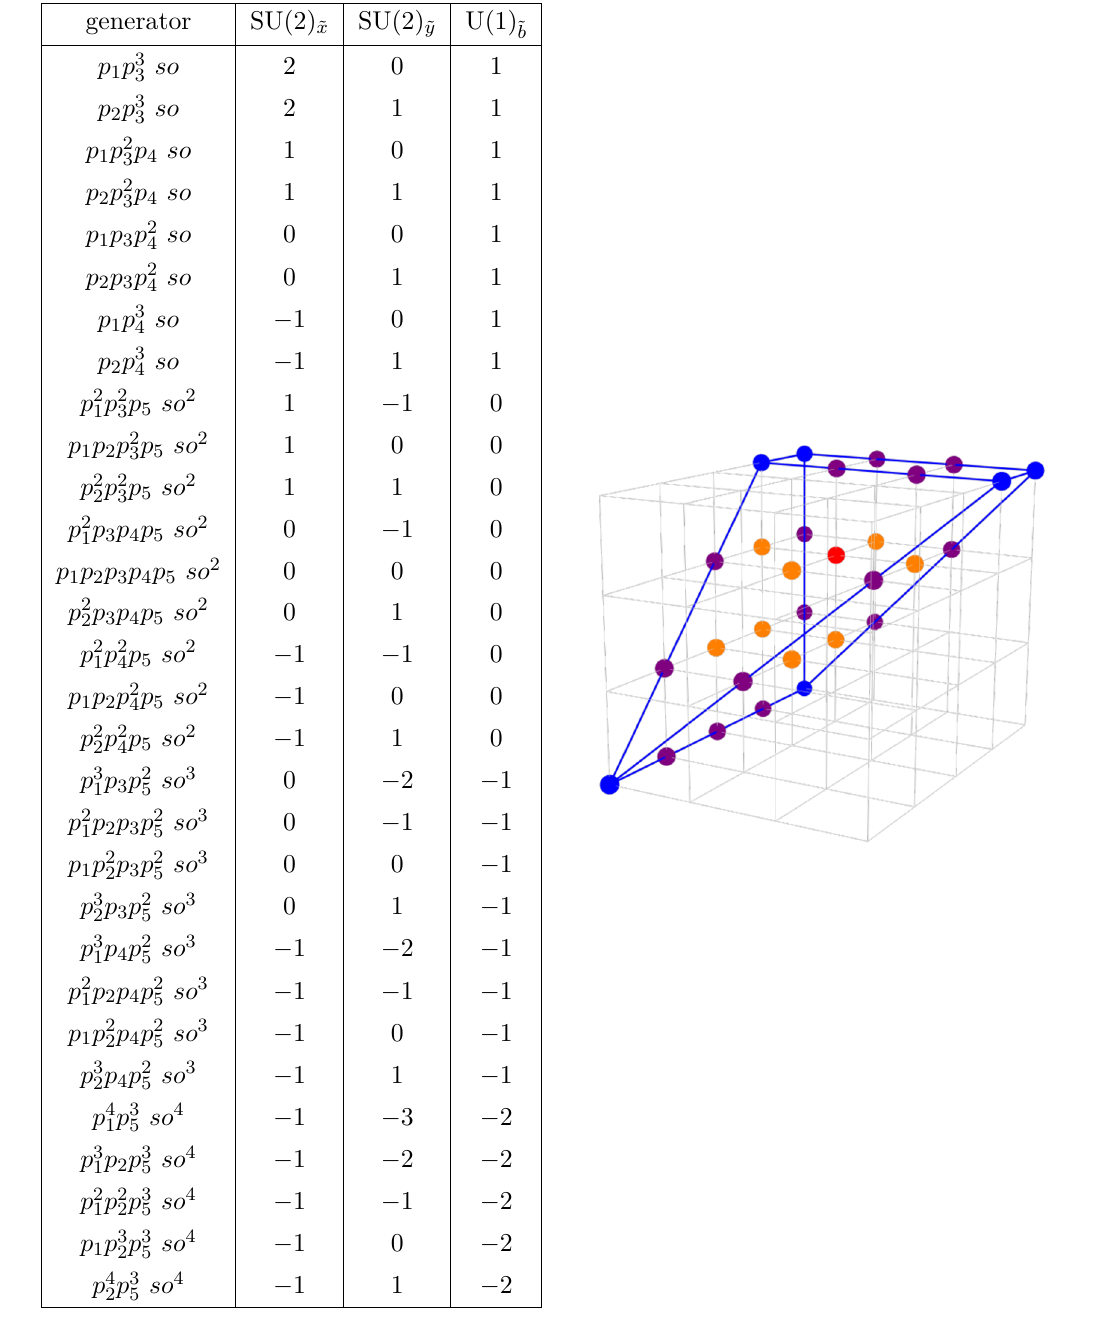
Table 16 . The generators and lattice of generators of the mesonic moduli space of Model 4 in terms of brick matchings with the corresponding flavor